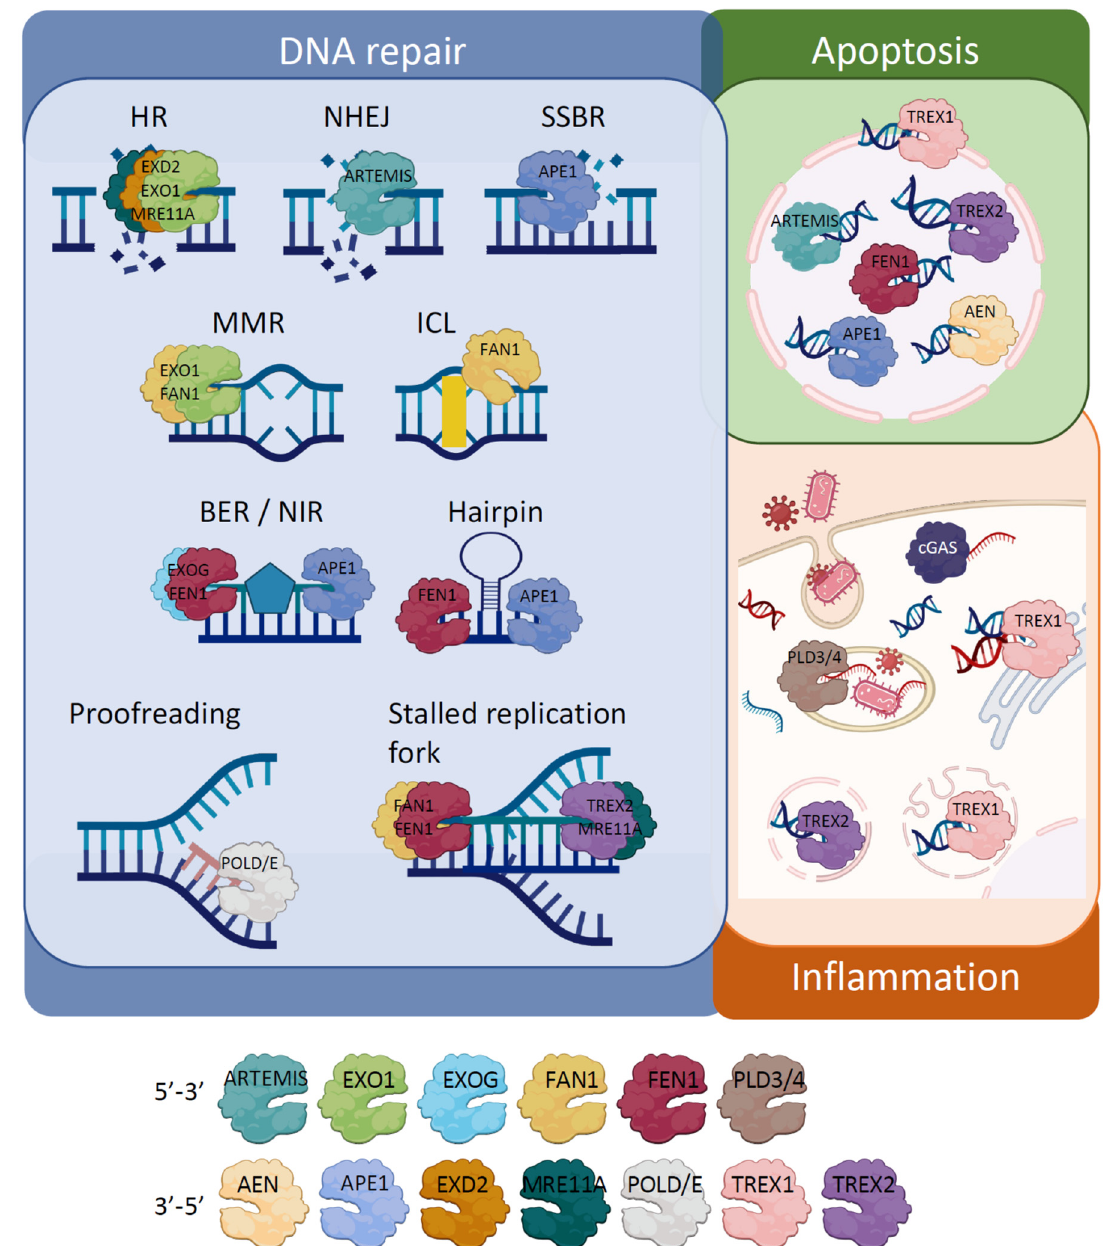
Figure 1. Exonucleases in DNA damage repair, apoptosis, and inflammation. Key exonuclease proteins in DNA damage repair, apoptosis, and inflammation processes are depicted. Exonuclease activity (5 ′ –3 ′ and 3 ′ –5 ′ ) is shown.